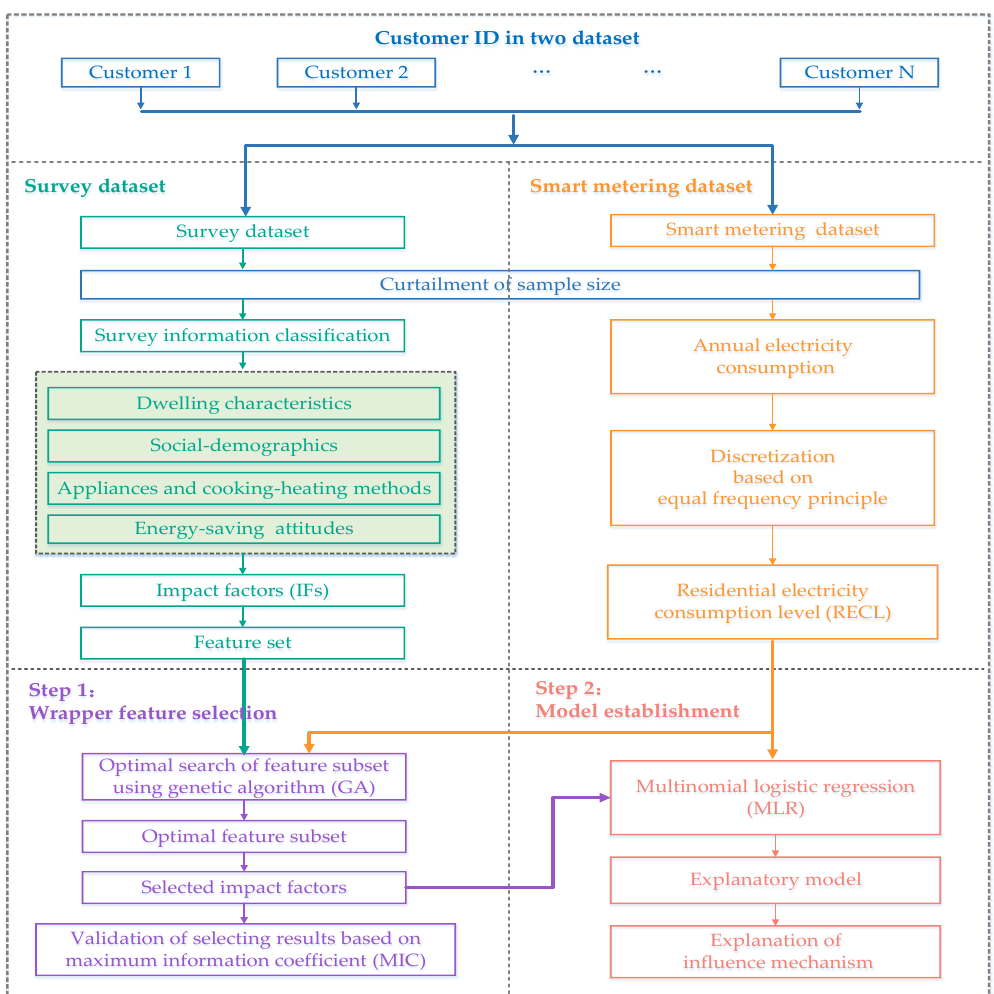
Figure 1. The framework of the proposed method.